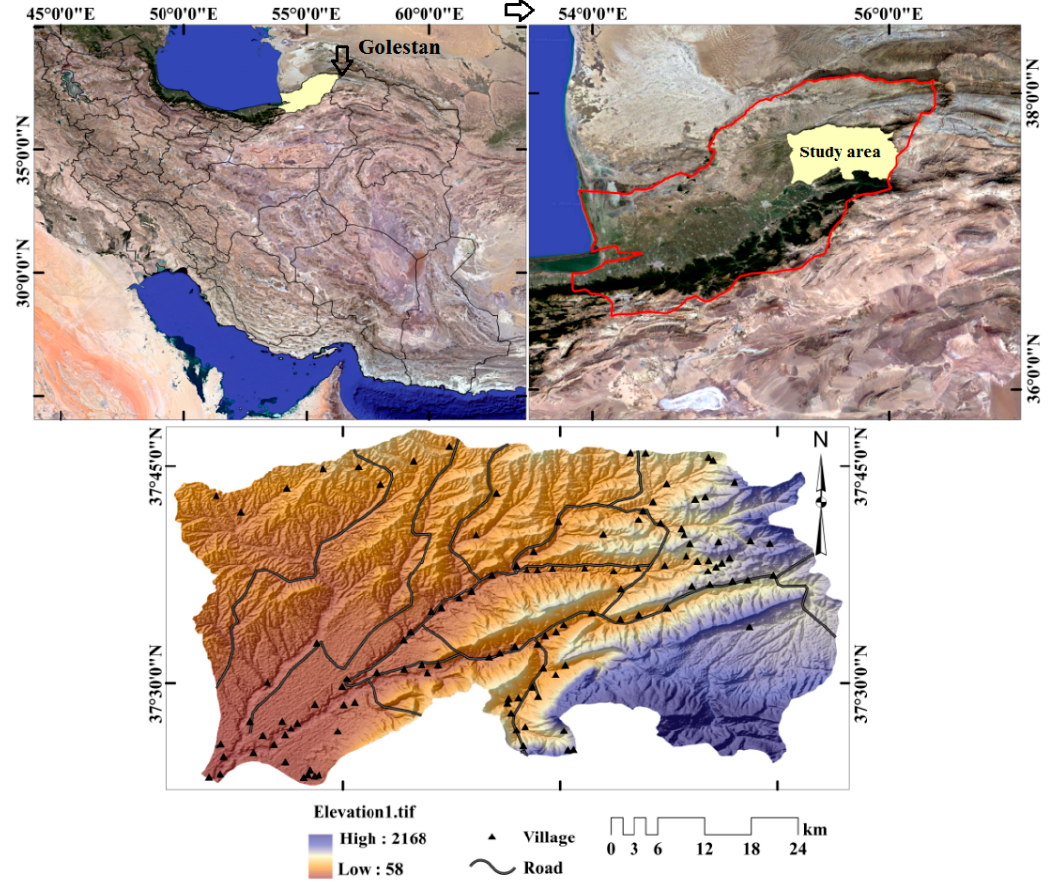
Figure 1. Location of study area. Table 1. Land use classes in the study area.